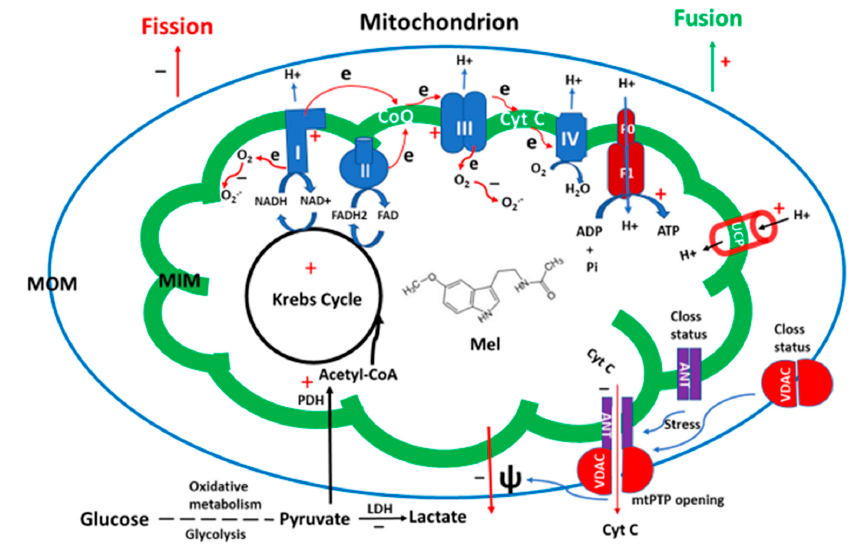
Figure 2. The potential e ff ects of melatonin on mitochondria. MOM: mitochondrial outer membrane, MIM: mitochondrial inner membrane, ψ : mitochondrial membrane potential, UCP: uncoupling protein, mPTP: mitochondrial permeability transition pore, Cyt C: cytochrome C, VDAC: voltage dependent anion channel, ANT: adenine nucleotide translocase or ADP / ATP carrier, LDH: lactate dehydrogenase, PDH: pyruvate dehydrogenase, Mel: melatonin, red + : stimulating e ff ects of melatonin, black − : suppressive e ff ects of